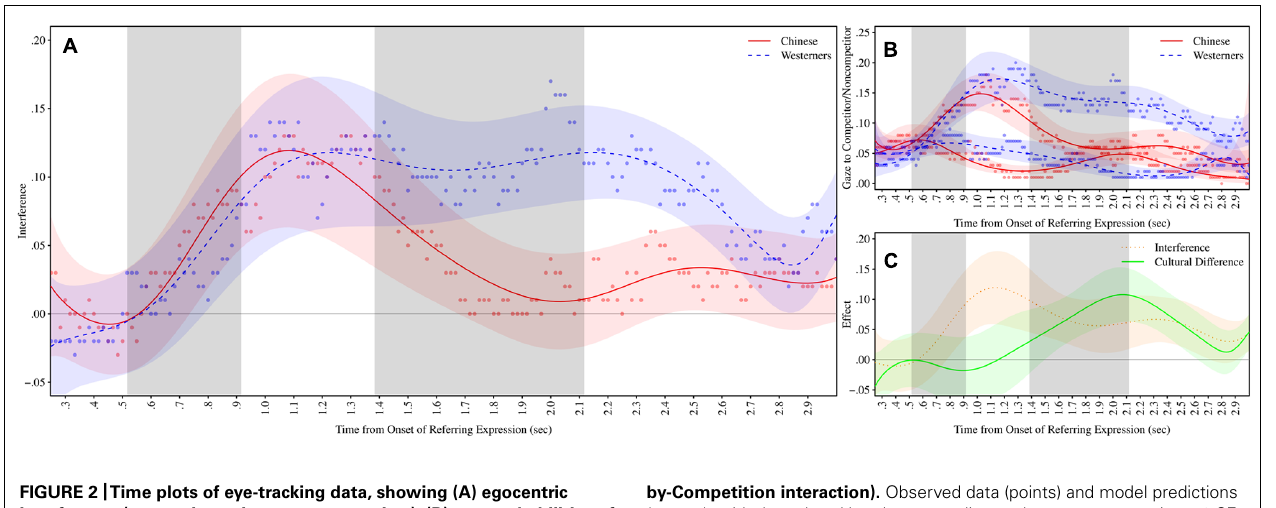
FIGURE 2 |Time plots of eye-tracking data, showing (A) egocentric interference (competitor minus non-competitor); (B) raw probabilities of gazing at the competitor (higher red/blue lines) and non-competitor (lower red/blue lines); and (C) time-course of egocentric interference (main effect) against the cultural difference in interference (Culture-